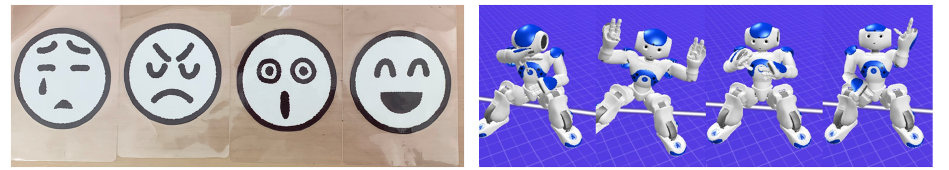
Figure 3. ( Left ) facial-expression cards, from left, sad, anger, surprise, happy; ( right ) the expressions by NAO, from left, sad, anger, surprise,